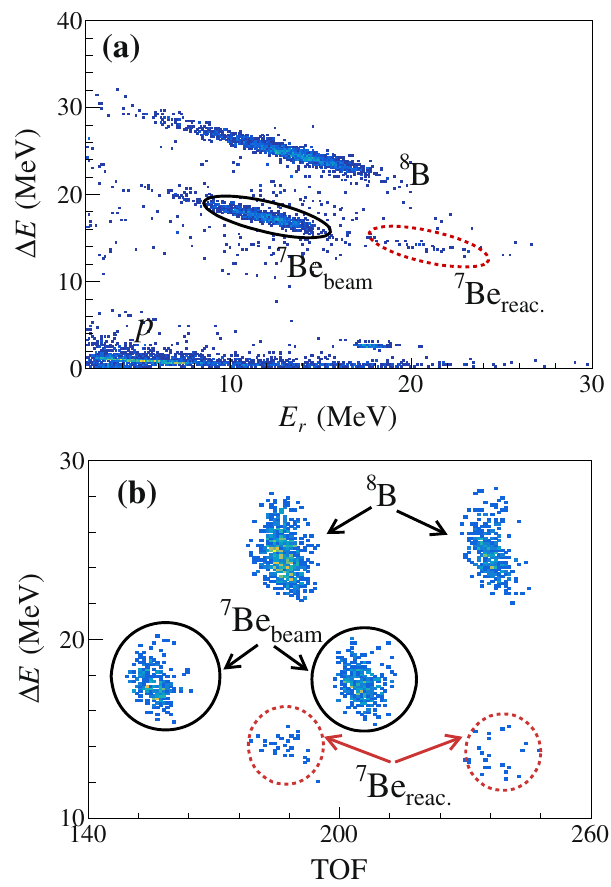
Fig.6|Particleidenti fi cation.a Typical Δ E − E r spectrumat46.1MeV,takenbyone strip of the forward-angle telescope, covering the polar angular range of 30.4 ∘ – 50.9 ∘ . b Δ E -TOF spectrum of two radio-frequency cycles illustrating the separationbetween the 7 Befrom 8 B reactions ( 7 Be reac. ) and elastically scattered 7 Be in the secondary beam ( 7 Be beam ), as surrounded by the dashed and solid circles,